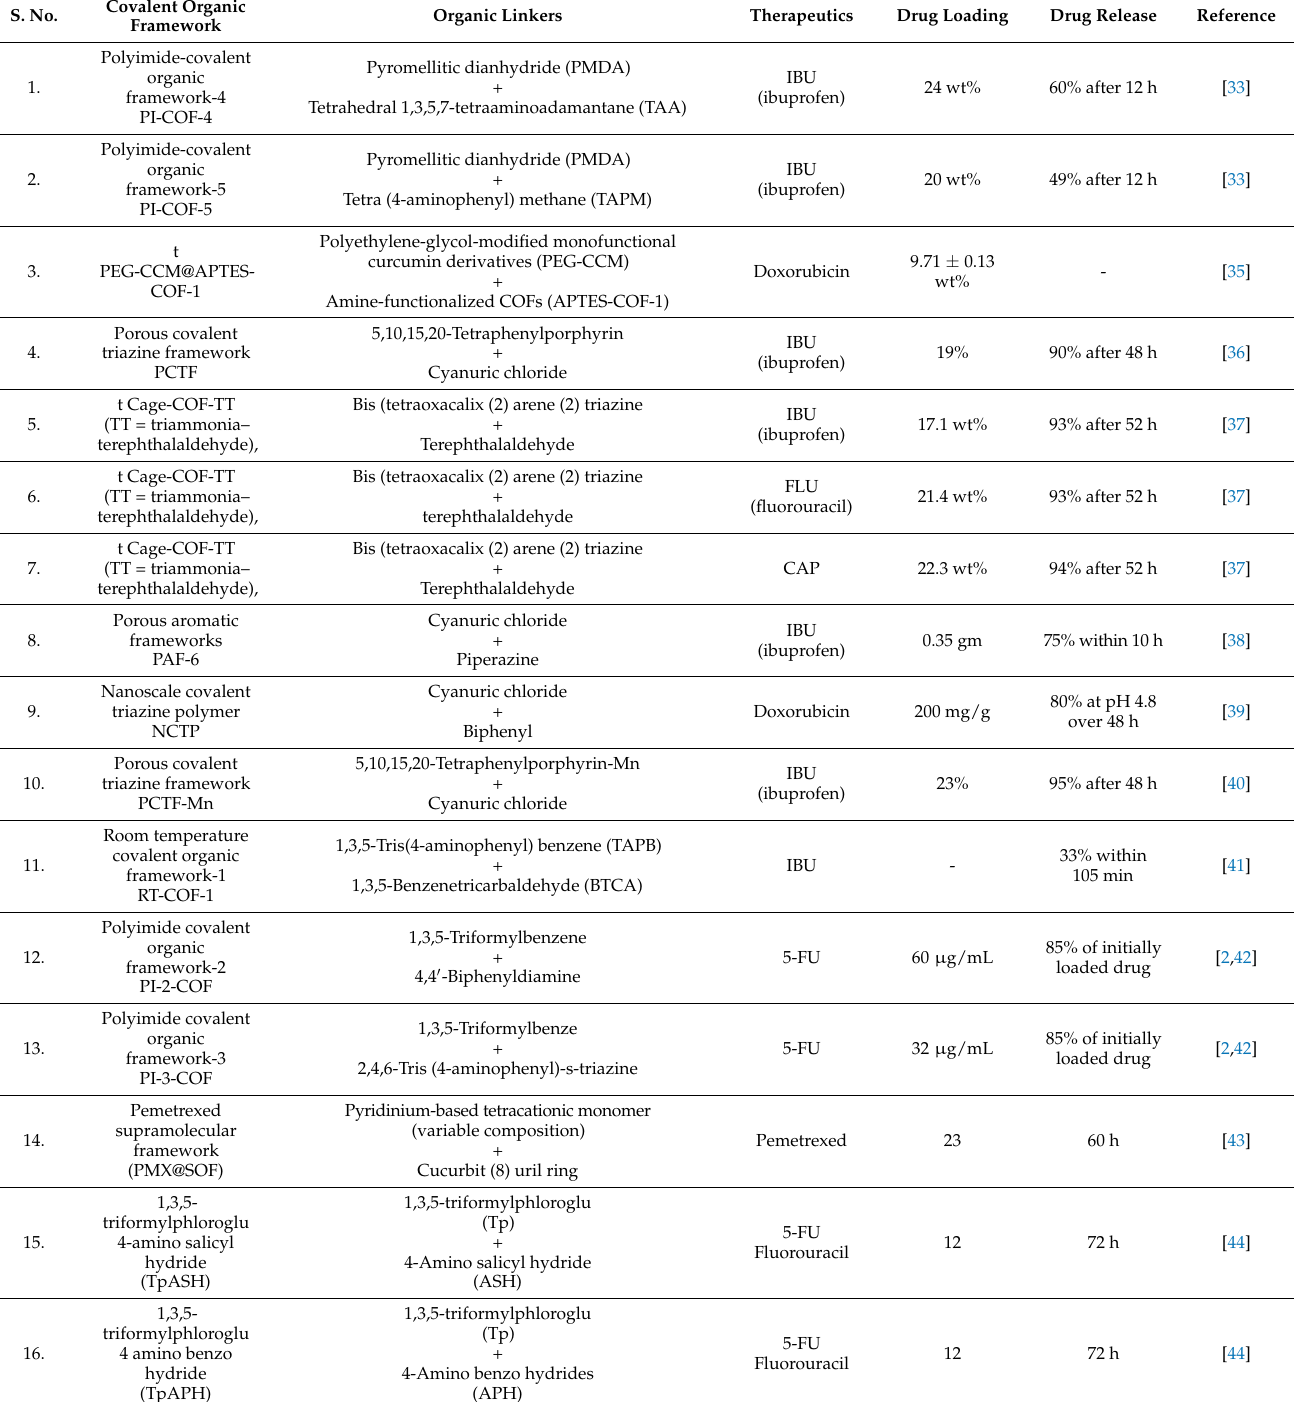
Table 3. List of newly reported COFs for biological